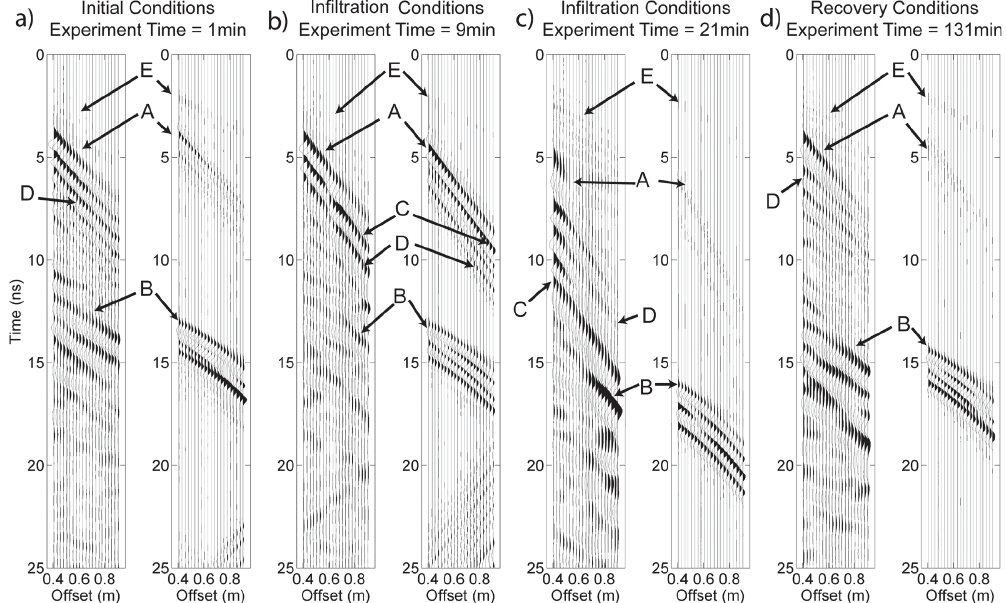
Fig. 5. Multi-offset GPR sections at 1, 9, 21, and 131min into the experiment are shown to represent initial, infiltration, and recovery conditions, respectively. For each time, data from the lab experiment are shown on the left and simulated data are shown on the right. Visible arrivals include the groundwave (A), bottom of sand reflection (B), the wetting front reflection (C), side of tank reflection (D), and airwave